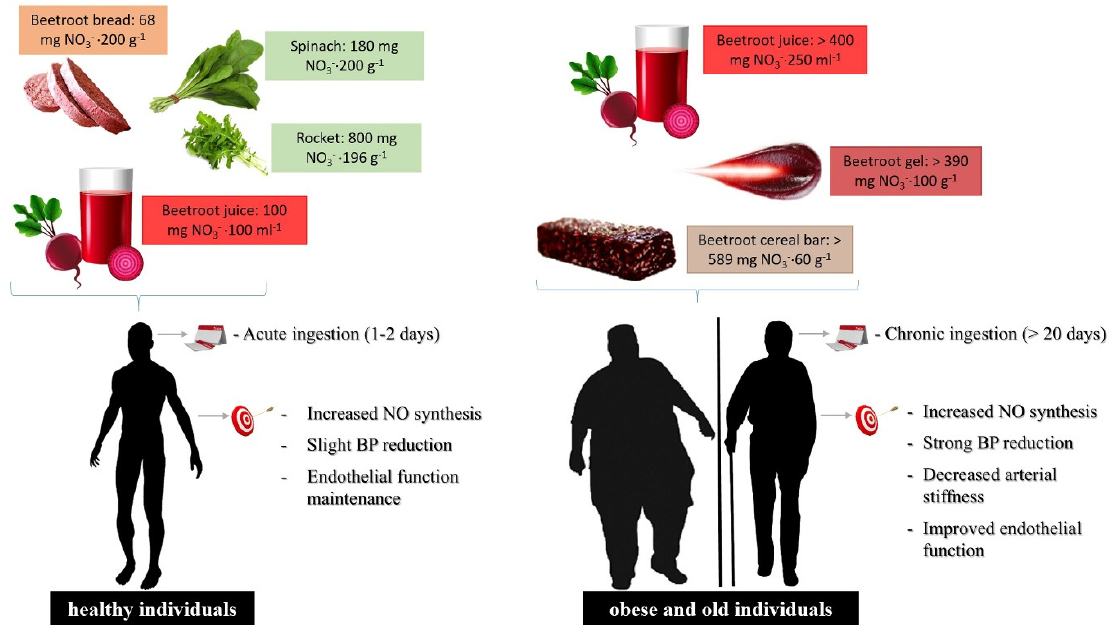
Figure 2. Food formulations and supplementation regimen of dietary NO 3 − in healthy or cardiovascular-compromised patients. For individuals presenting risk factors for the development of cardiovascular disease, the dietary NO 3 − dose should be higher to promote the systemic elevation of plasma NO 3 − and NO 2 − levels compared to healthy individuals, increasing NO generation by the NO 3 − /NO 2 − pathway, where increased levels must be administered through chronic and uninterrupted supplementation.